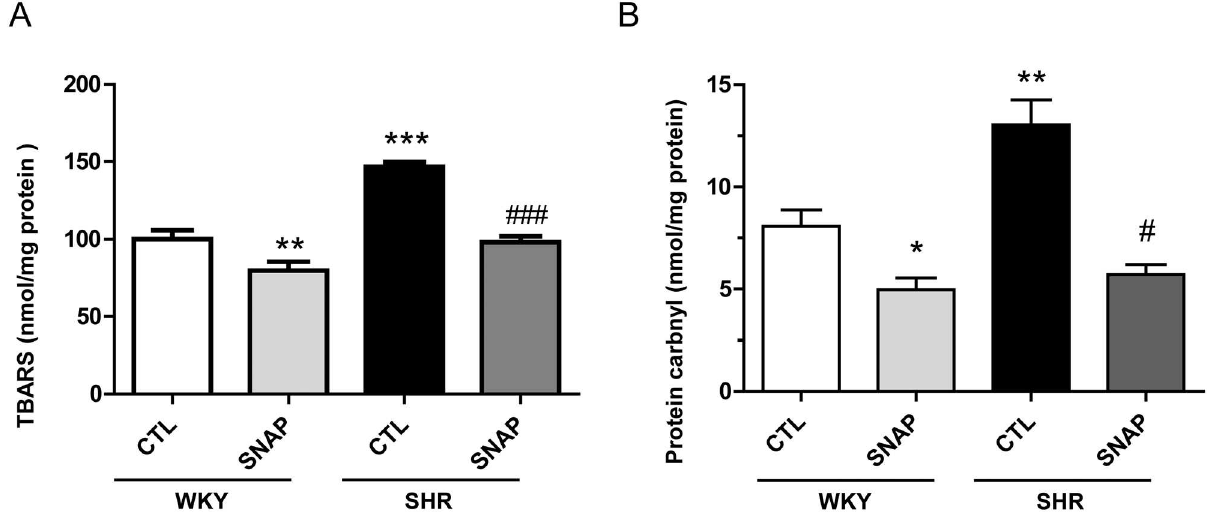
Fig 7. Effect of SNAP in TBARS and protein carbonylation in aortic VSMC from 12-weekold SHR and age-matchedWKY rats. ConfluentVSMC from 12-week-old SHR and age-matched WKY rats were incubatedin the absence(control) or presence of SNAP (100 μ M) for 24 h. Cell lysates were preparedand the levels of TBARS (A) or protein carbonyls(B) were determined as describedunder Materials and methods Results were expressedas percentage of the WKY control (CTL), which was taken as 100%. Values are the Mean ± SD of 3 separateexperiments using different cell populationsfrom different animals. * P < 0.05, ** P < 0.01, *** P < 0.001vsWKY CTL group; # P < 0.05, ### P < 0.001vs SHR CTL group.